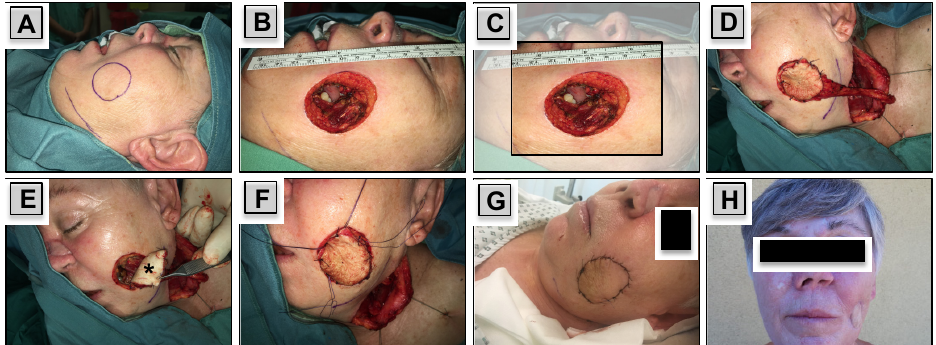
Figure 2. Reconstruction of a Through-and-Through Defect. A 60-year-old female patient experienced regional failure of a sinonasal carcinoma. Radical tumor resection was performed, resulting in creation of a through-and-through defect with 4.0 × 5.0 cm in size ( A – C ). A free radial forearm free flap (RFFF) was used for reconstruction. The harvested skin paddle was used for the outer lining ( D , F ), while full thickness skin graft of the neck (asterisk) was used for inner lining ( E ). Postoperative ( G ) and 2 year follow up results are shown ( H ). The reconstructed region on the left side of the nasal dorsum ( D – G ) represents the former tumor infiltrated area that has been resected and reconstructed.